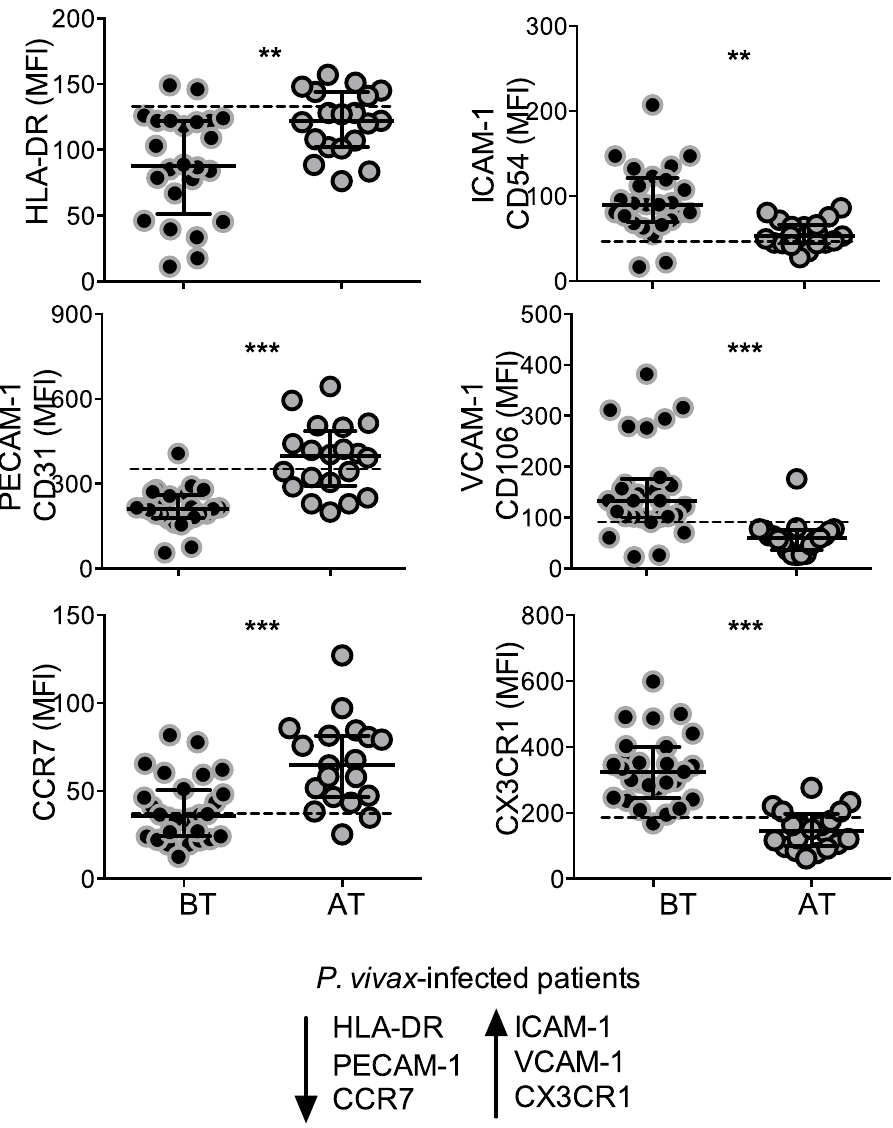
Figure 2. P.vivax infection alters the expression of activation markers, adhesion molecules and chemokine receptors on circulating monocytes. Mean fluorescence intensity (MFI) of HLA-DR (BT, n=24 and AT, n=19), CD31 (BT, n=25 and AT, n=20), CCR7 (BT, n=28 and AT, n=19) (left panels, from the top to the bottom), CD54 (BT, n=25 and AT, n=19), CD106 (BT, n=28 and AT, n=19), CX3CR1 (BT, n=28 and AT, n=20) (right panels, from the top to the bottom) was evaluated on monocytes from P. vivax -infected subjects, before (BT, black circles) and 30–45 days after treatment (AT, grey circles). Circles indicate individual patients and lines represent median values and interquartile ranges. Dotted lines represent medians of a given measurements from healthy donors. Levels of the molecules above were measured by flow cytometry. **0.05 . p . 0.01, *** p , 0.01. expression was observed for TNFR1/TNFRSF1A and ICAM-1 in the heatmap, once the range from 2 4.0 to + 4.0 fold was with CD14 + CD16 2 and CD14 + CD16 + expressing higher levels selected to better reveal differences in the majority of the genes induced by malarial infection in monocyte subsets. Once changes than CD14 lo CD16 + monocytes (Figure 4C). The classical mono- in gene expression were detected upon P. vivax infection, the cytes, CD14 + CD16 2 expressed higher counts of mRNA for the expression of each of these genes was compared among the receptor for IFN-gamma and for the IL-1 receptor agonist IL-1RA monocytes subset from P. vivax -infected patients (Figure 4C). In (Figure 4C). The expression of cytokine genes also varied among general, the CD14 + subpopulations, i.e. , the classical and monocyte subsets. Both IL6 and IL10 had higher expression in CD14 + CD16 + compared to CD14 + CD16 2 cells. CD14 lo CD16 + inflammatory monocytes, expressed higher levels of RNAs encoded by pro-inflammatory genes. The chemokines CCL2 monocytes expressed higher levels of mRNA for TNF and lower and CXCL2 were highly expressed by CD14 + CD16 2 and levels of IL8 than the CD14 + CD16 2 subset. CD14 + CD16 2 as CD14 + CD16 + subpopulations, but were expressed at lower levels well as CD14 + CD16 + monocytes expressed higher amounts of by CD14 lo CD16 + monocytes (Figure 4C). The same pattern of NLRP3 and CASPASE1 than patrolling monocytes. The same